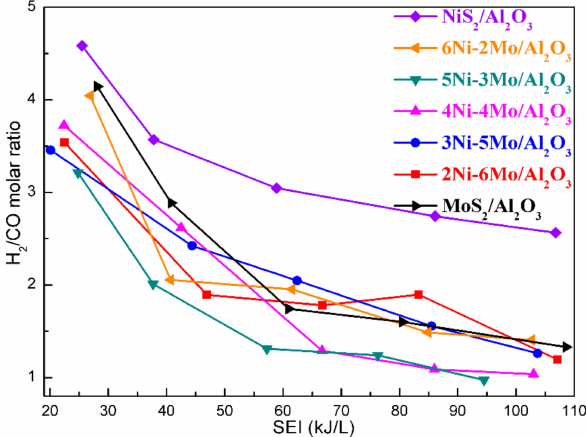
Figure 6. CO concentration ( a ) and H 2 concentration ( b ) in gas product as a function of SEI in the plasma-induced CO 2 and H 2 S conversion on the Ni-Mo sulfide / Al 2 O 3 catalysts with various Ni / Mo molar ratios. Reaction conditions: feed: H 2 S / CO 2 molar ratio = 20:15; flow rate: 35 mL / min; catalyst bed volume: 15.0 mL.